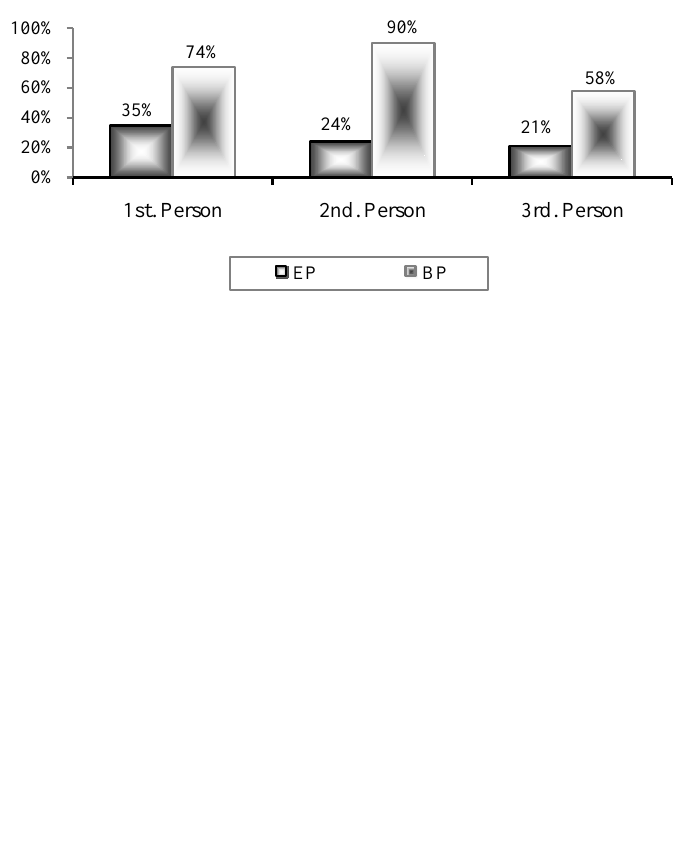
Figure 3. OVERT SUBJECTS IN SPOKEN "EP" AND